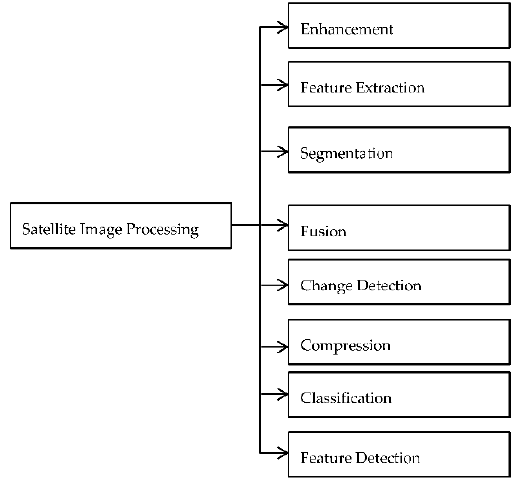
Figure 1. Image processing